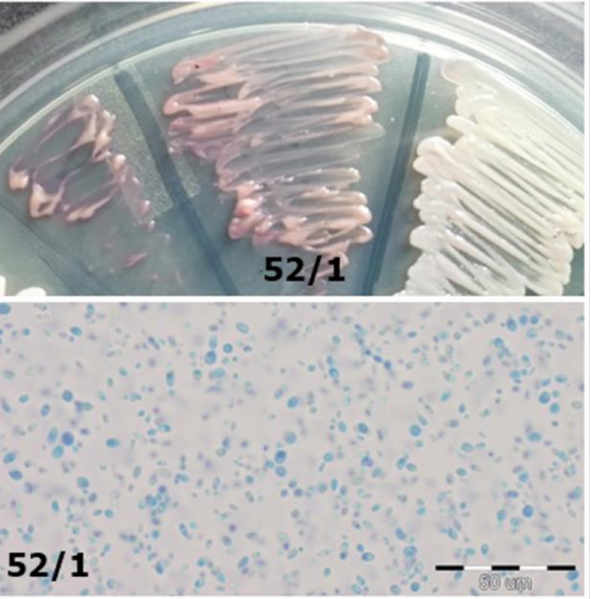
Figure 4. Strain 52/1-morphology on CHROMagar Candida and 40 × zoom (Lactophenol Cotton Blue; private